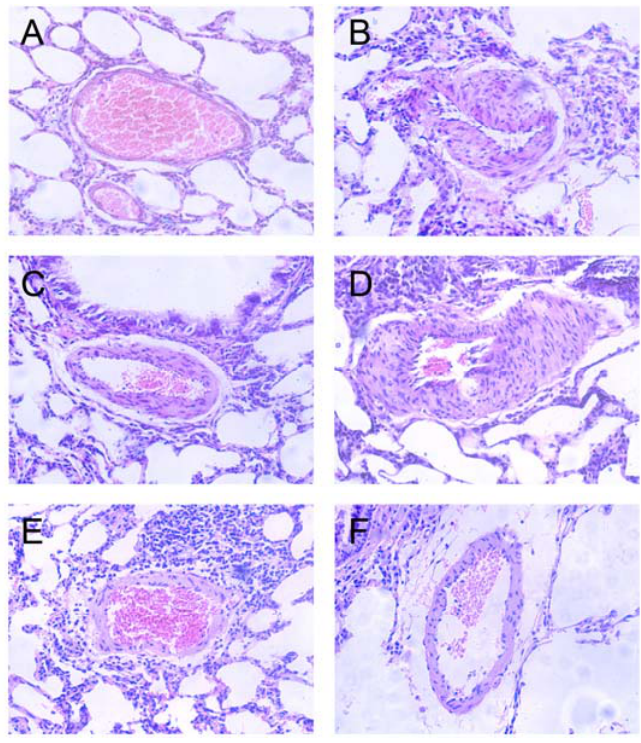
Figure 2. Effects of polydatin on pulmonary artery morphology during hypopiesia and hypoxia (HE staining, at 200× magnification). ( A ) normoxic group; ( B ) hypobaric and hypoxic group; ( C ) silaenafil group; ( D ) 5 mg/kg polydatin group; ( E ) 10 mg/kg polydatin group; ( F ) 20 mg/kg polydatin